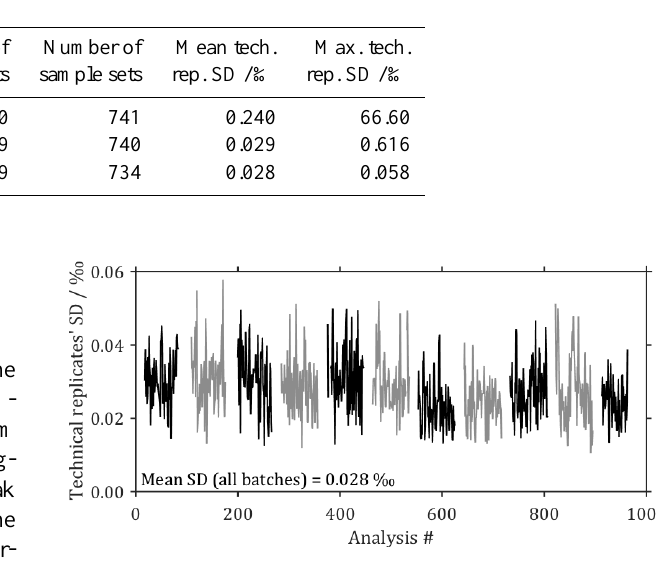
Figure 4. Standard deviation (SD) of technical replicates for each seawater sample, after anomalous peak removal. Alternating black and grey sections indicate separate analysis batches.